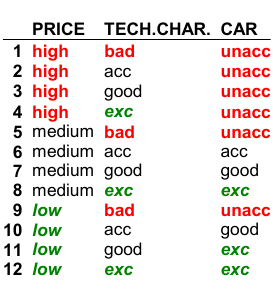
Figure 3. Decision rules for aggregating PRICE and TECH.CHAR. to CAR. The aggregation in DEX is defined by decision tables consisting of decision